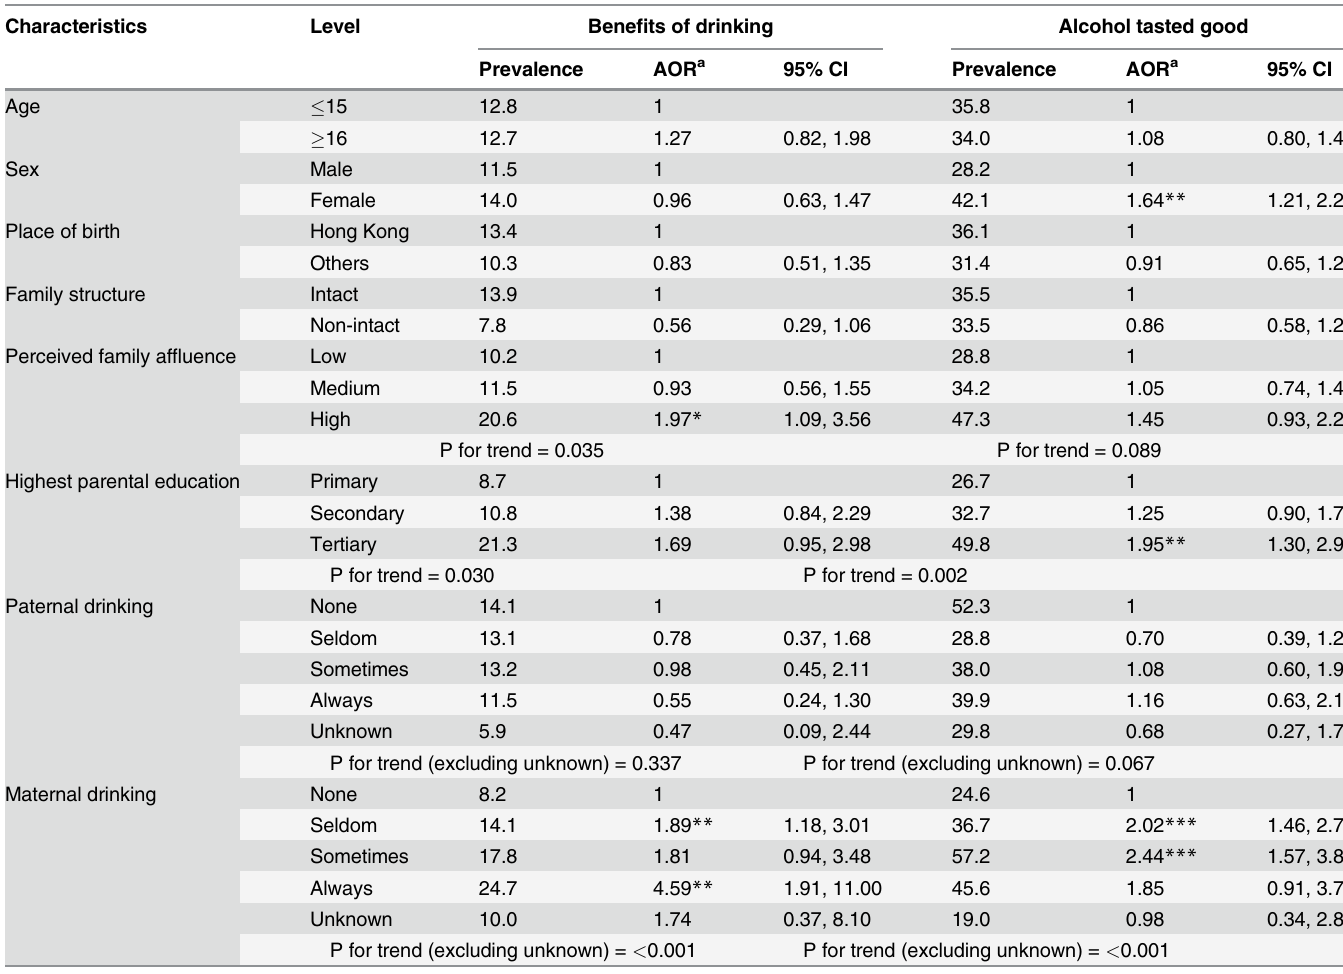
Table 3. Prevalence and adjusted odds ratios (AORs) for parents being heard saying the bene fi ts of drinking and alcohol tasted good.